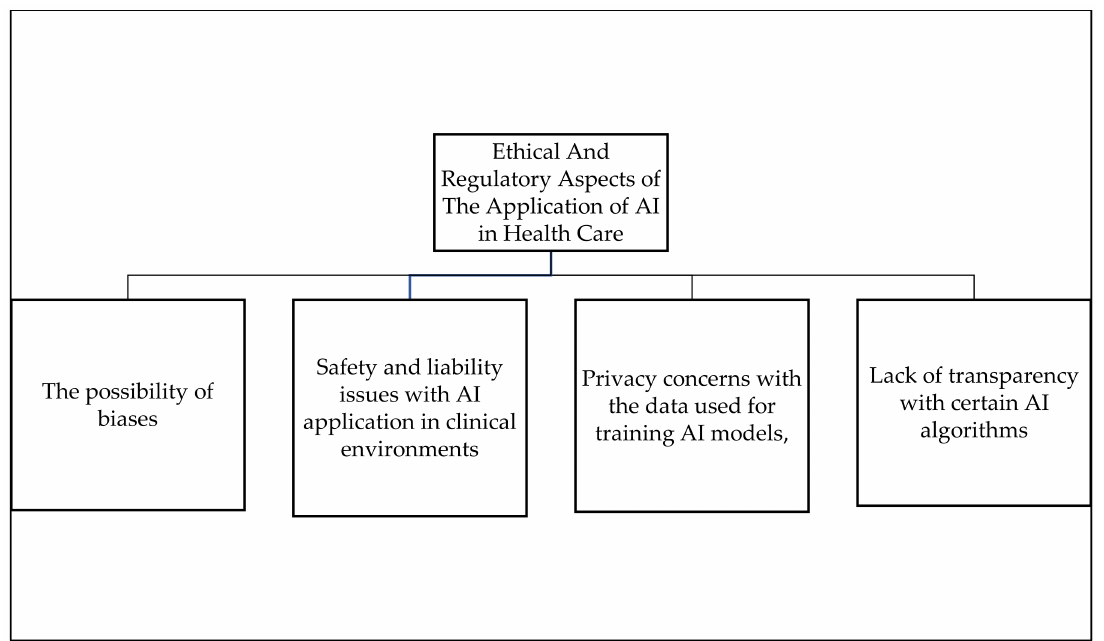
Figure 5. Ethical and Regulatory Aspects of the Application of AI in Health Care. Source: Author’s